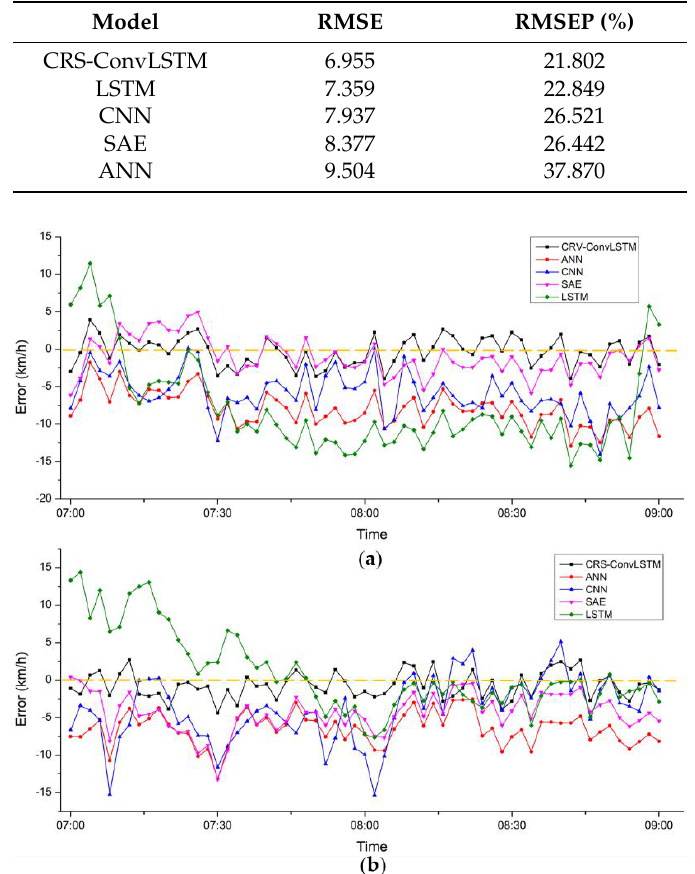
Figure 9. Errors between the ground truth and the estimated value on: ( a ) 3 August 2015 and ( b ) 17 August 2015.